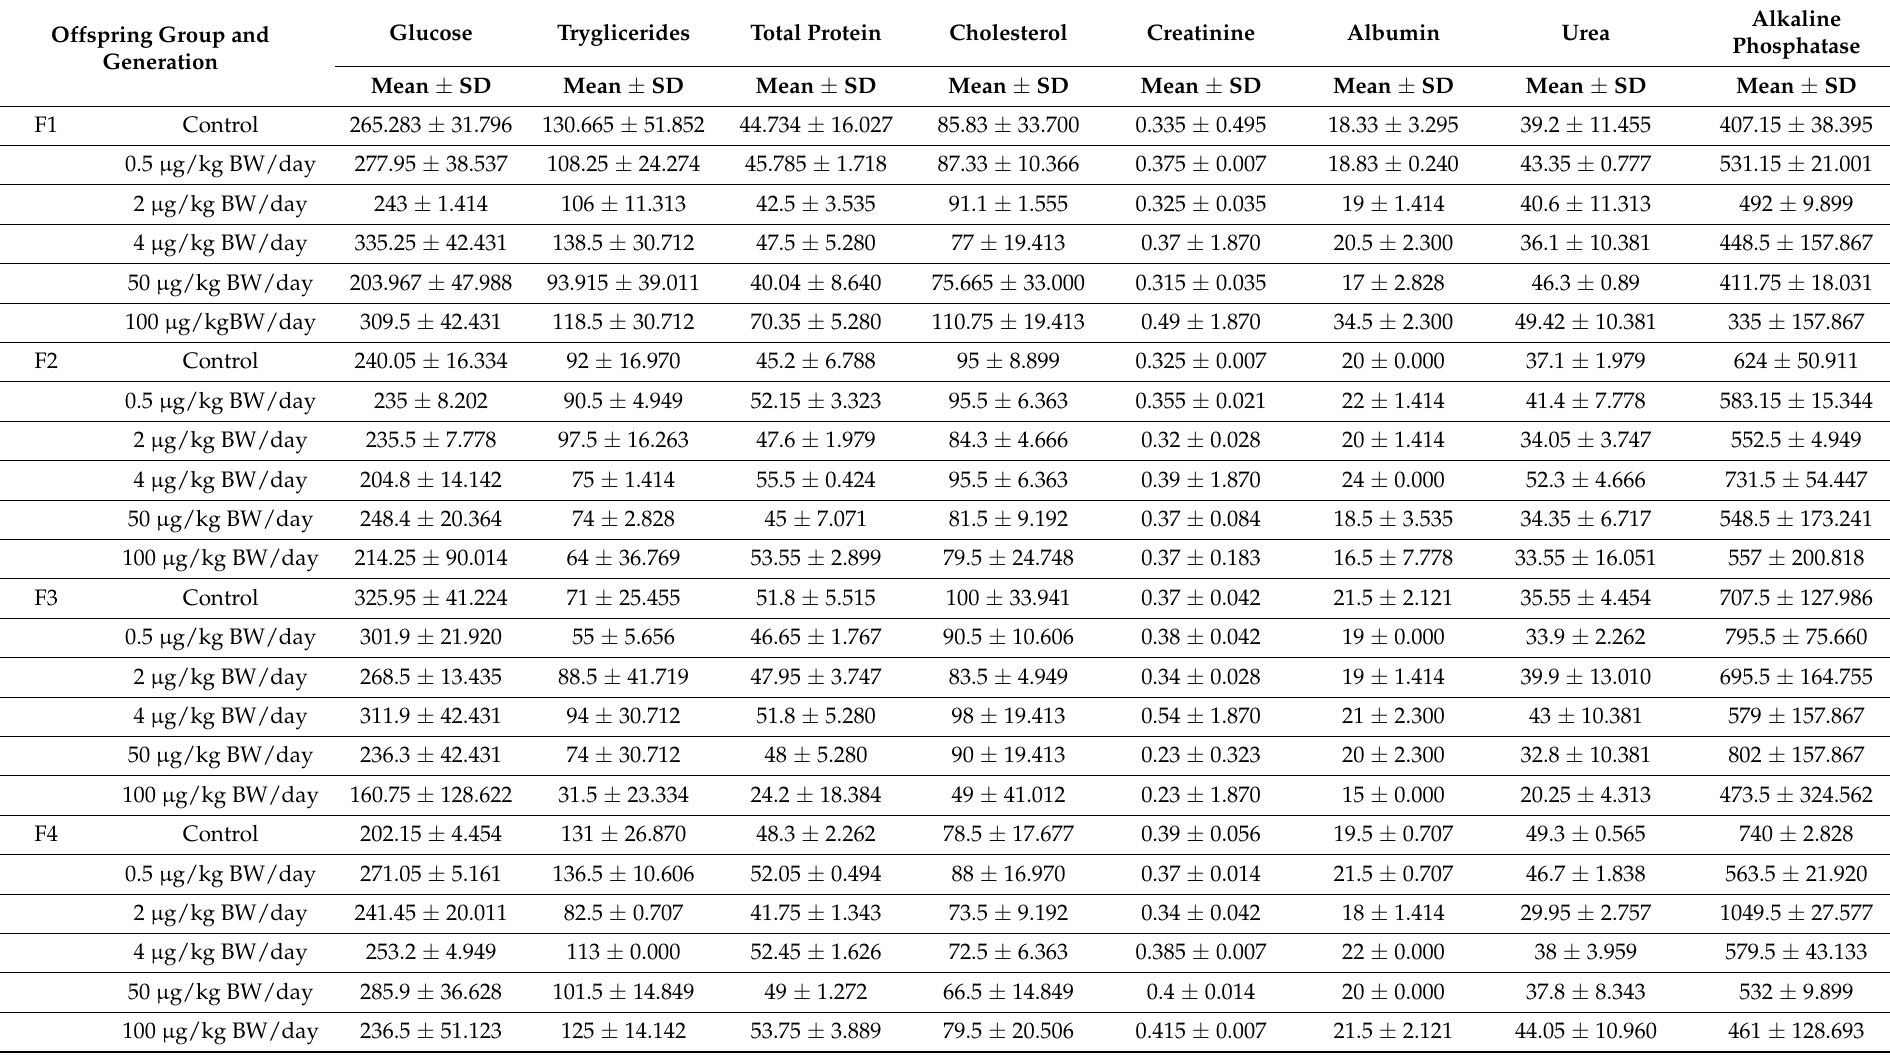
Table 6. Mean values ± standard deviations of the biochemical parameters in the different generations and exposure groups of